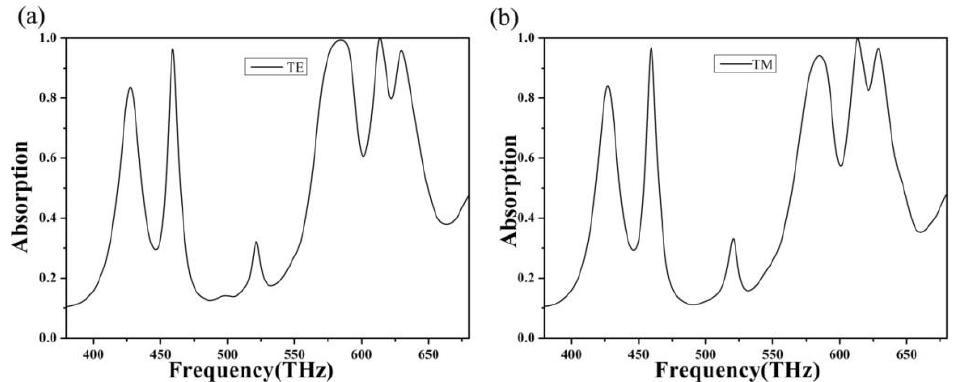
Figure 2. ( a ) The absorption curve under TE polarization, and ( b ) the absorption curve under TM polarization.